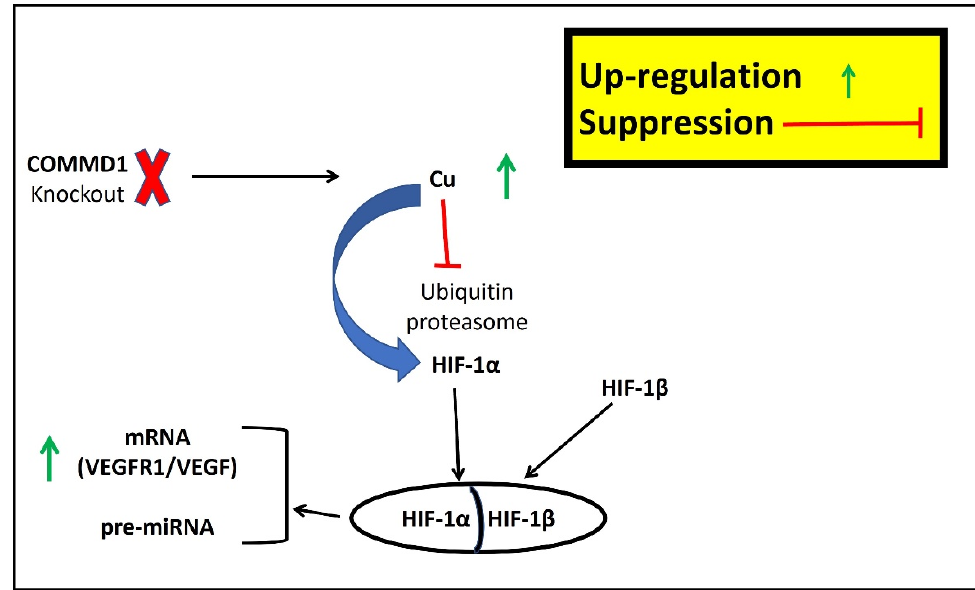
Figure 3. Hypothetical model of HIF-1 regulation by COMMD1. COMMD1 knockout prevents Cu loss in the cardiomyocyte after myocardial infarction (MI). Increased Cu levels induce HIF-1 α stabilization and HIF-1 migration in the nucleus. Cu stabilizes HIF-1 through inhibition of the ubiquitin-proteosome complex which, under normal oxygenation, degrades the HIF-1 α subunit and prevents formation of the HIF-1 α /HIF-1 β heterodimer. Cu might have a dual action on HIF-1, as it acts on the formation of the HIF-1 α /HIF-1 β heterodimer but also on its transcriptional activity, because Cu’s absence blocks insulin-like growth factor-1 (IGF-1) and vascular endothelial growth factor (VEGF) expression. Cu levels increasing induces an increase in mRNA linked to VEGF production and simultaneously induces the maturation of hypoximirs. COMMD1 plays a key role in this cascade mechanism, as its deletion has been shown to reduce Cu loss after hypoxic injury.